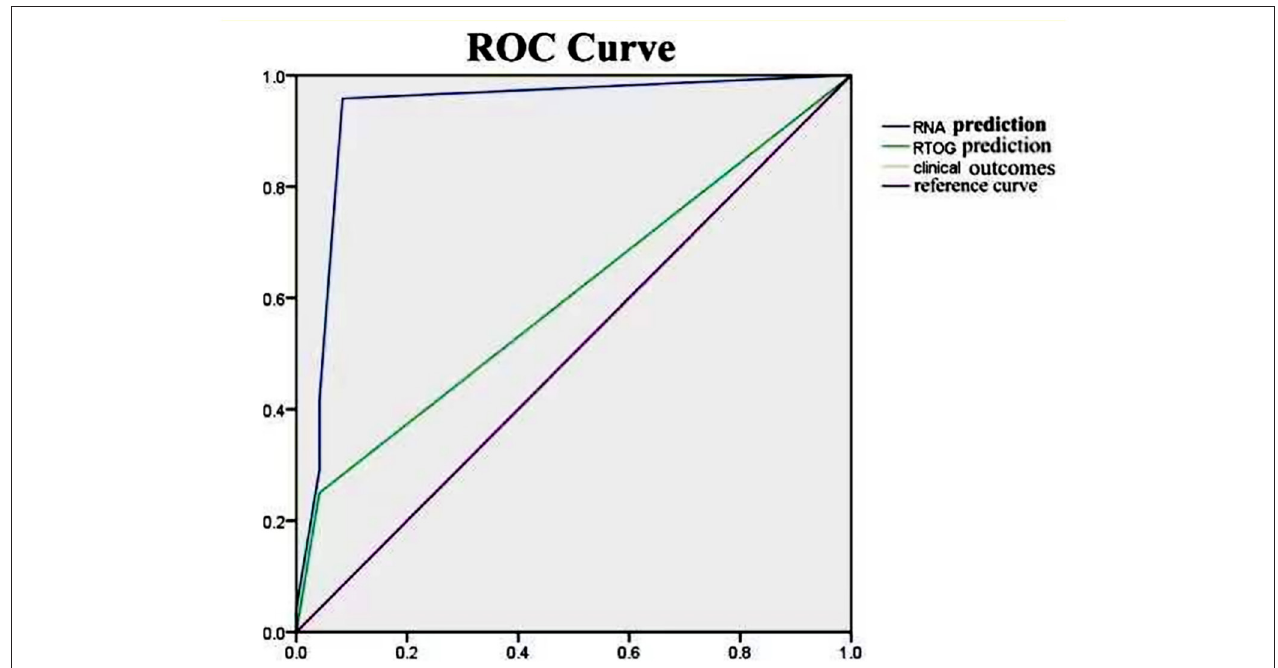
FIGURE 5 | ROC curve of RP prediction results and clinical observation results based on the RNA sequencing and RTOG physical parameters. The chart compares the prediction results among the RILI, RTOG, and clinically observed RP outcomes. The prediction results of RILI and RTOG have AUC of 0.933 and 0.604, respectively. This indicates that the prediction results of RILI are significantly better than those of